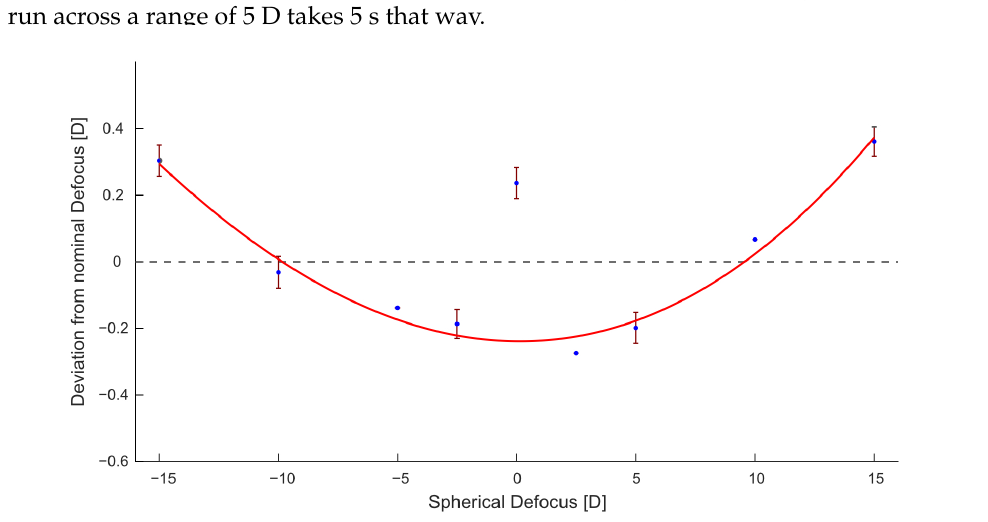
Figure 3. Results of all spherical defocus